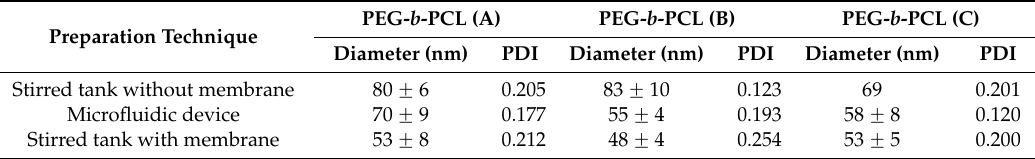
Table 3. The mean diameter of the drug-free micelles prepared using three copolymers dissolved in acetone from three different preparation techniques. The organic phase was 1 mg ¨ mL ´ 1 PEG- b -PCL in